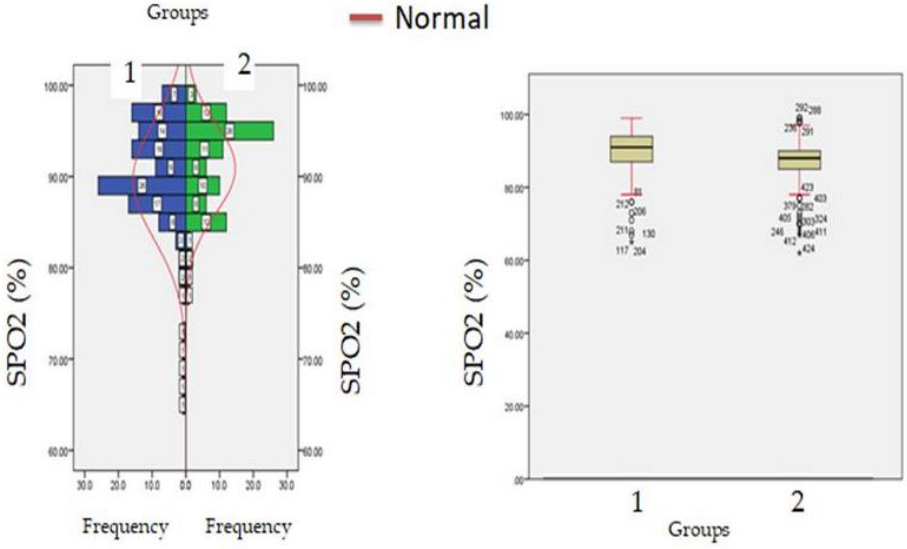
Figure 1. SpO 2 levels at admission (hospitalization) in patients with normocreatinemia (Group-I) and hypercreatinemia (Group-2). Table 1. Comparison of laboratory indices between COVID-19 infected hypercreatinemic and normocreatinemic sub-populations.